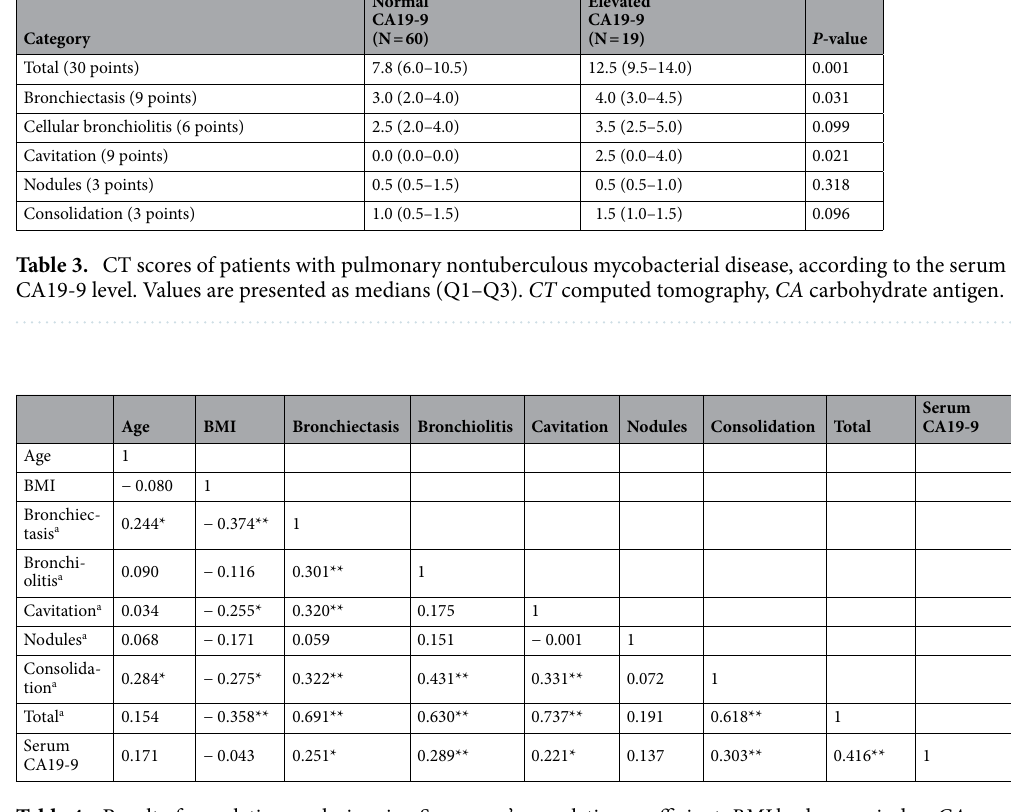
Table 4. Result of correlation analysis using Spearman’s correlation coefficient. BMI body mass index, CA carbohydrate antigen. *Level of significance is 0.05, **Level of significance is 0.01. a Categories of the computed tomography scoring